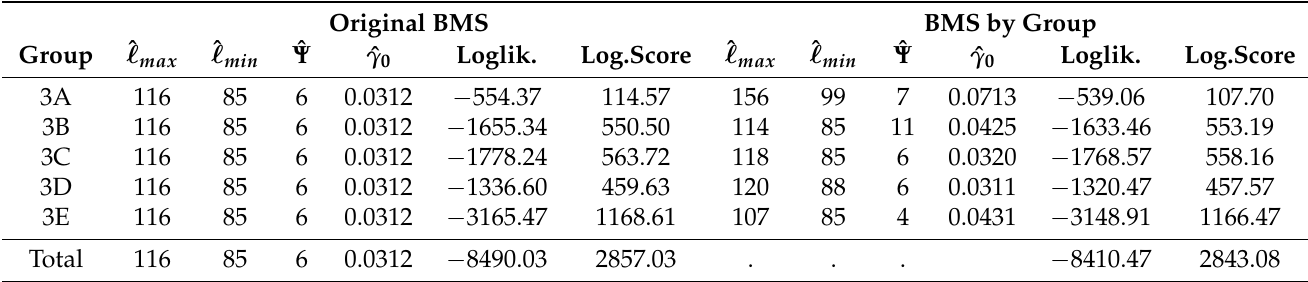
Table 5. Comparison of the original BMS and the BMS by group